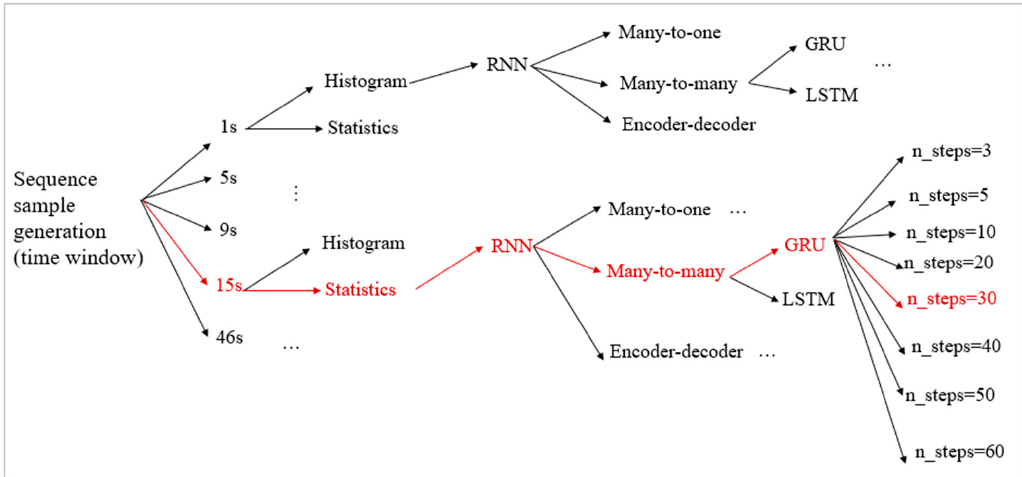
Figure 12. Work flow in the traffic noise modelling with Blansko data.